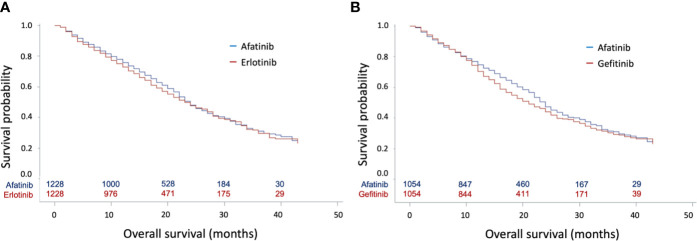
Kaplan–Meier curves for overall survival (OS) according to tyrosine kinase inhibitors (TKIs) in matched cohorts. (A) Kaplan–Meier curves for OS between matched afatinib and erlotinib users; (B) Kaplan–Meier curves for OS between matched afatinib and gefitinib users.